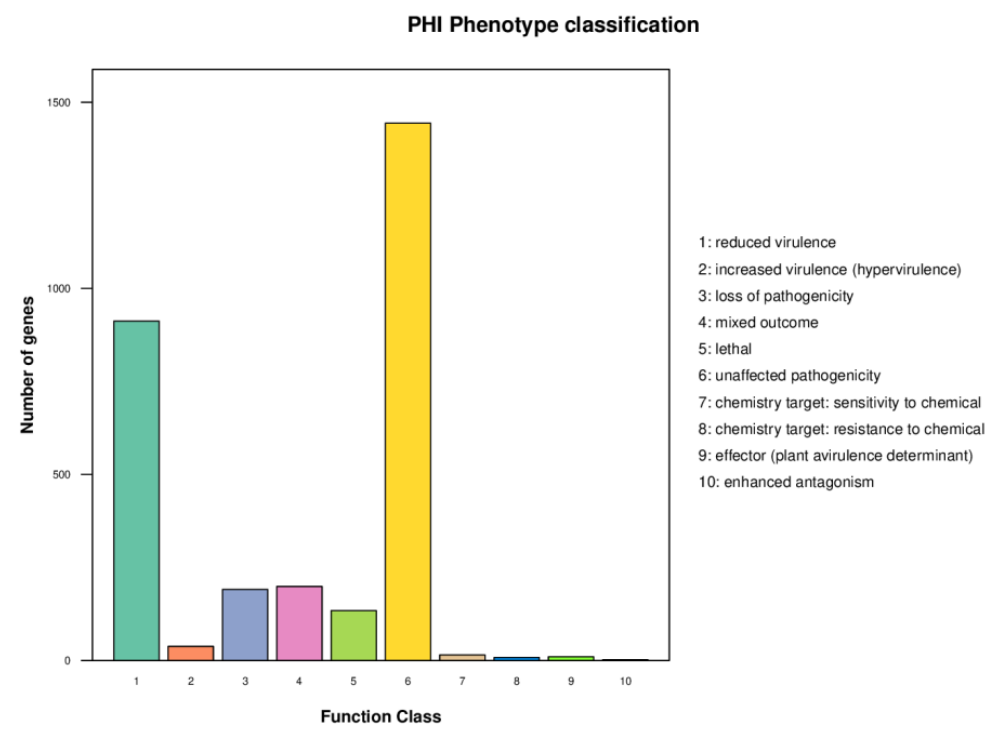
Figure 4. Distribution map of mutation types in the pathogen PHI phenotype of strain R1.